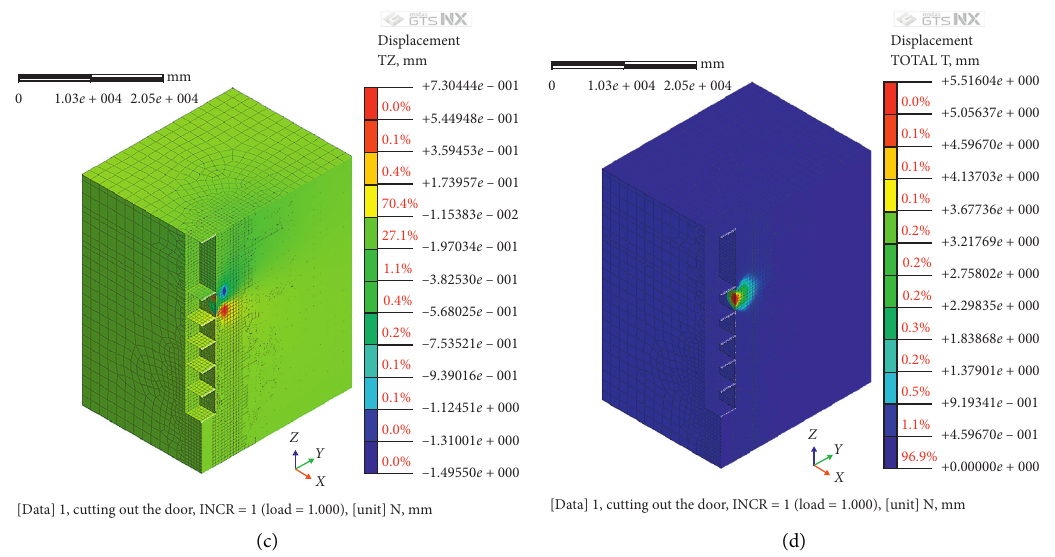
Figure 9: Soil displacement nephogram. (a) X-direction displacement. (b) Y-direction displacement. (c) Z-direction displacement. (d) Total